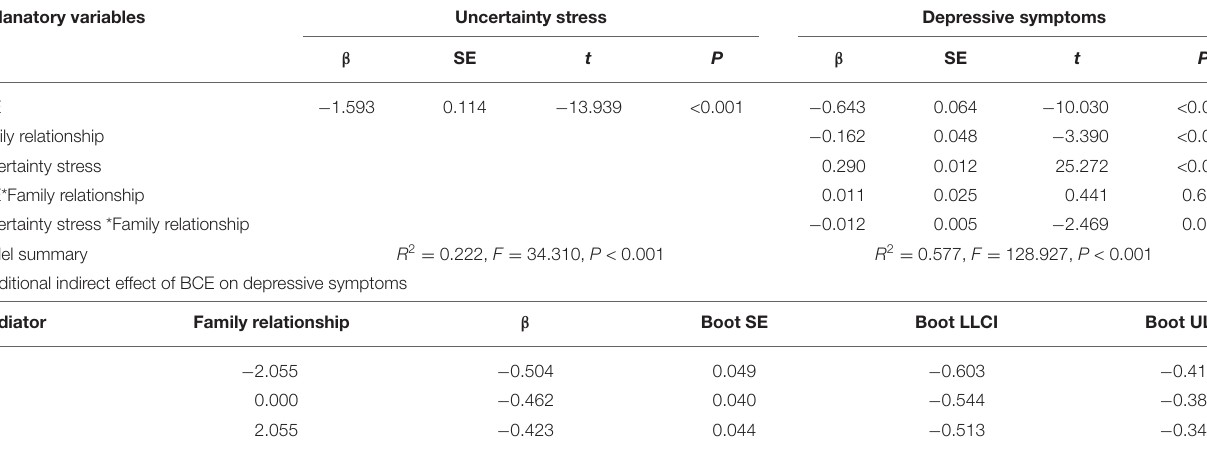
TABLE 3 | Regression coefficients predicting depressive symptoms, family relationship as moderator (moderated mediation model).